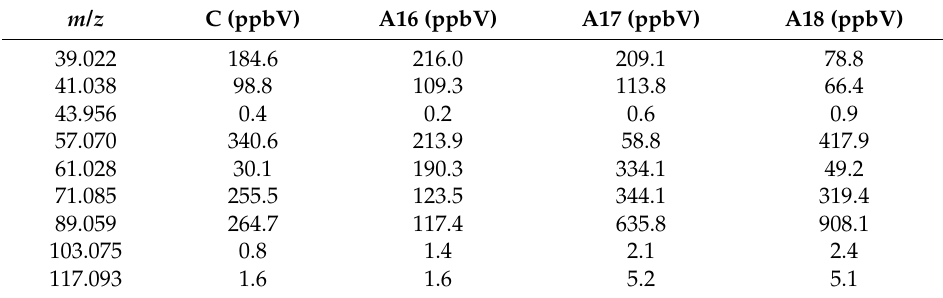
Table 3. Variations in terms of ppbV for mass peaks associated with the major ester fragments related to fragmentations involving the mass peak m / z 89.060, m / z 103.075 and m / z 117.093. Variations were calculated for C, A16, A17, and A18 comparing the concentration detected at cycle 20 with the concentration reported at cycle 24. These mass peaks are the more representative fragments for fragmentations involving the mass peaks m / z 89.060, m / z 103.075, and m / z 117.093, in accordance with fragmentation patterns describe in quality and quantity by Aprea et al. [32] m/z C (ppbV) A16